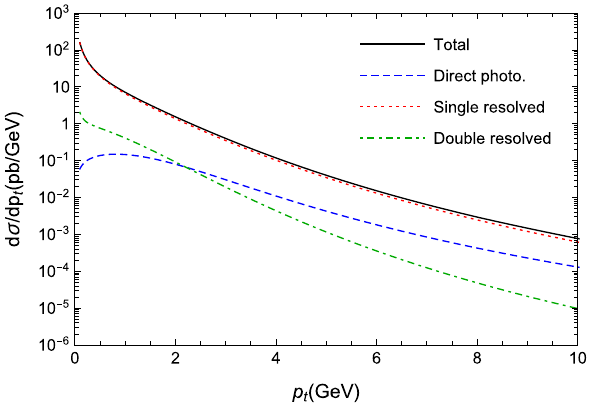
Fig. 3 The p t distributions of the cross section from direct photopro- duction and resolved photoproduction